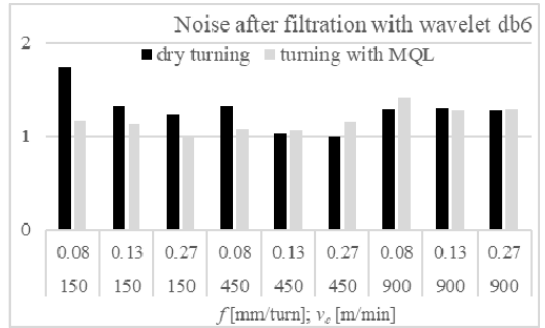
Figure 21. Noise and disturbance values in composite turning with polycrystalline diamond insert (CD10), obta– ined through filtration with wavelet Daubechies 6